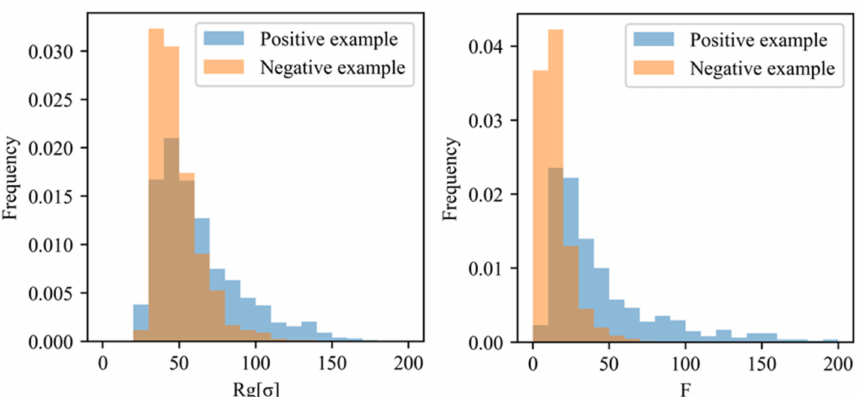
Figure 14. Histograms of the radius of gyration, R g , and the number of filler particles in the loop, F , of the filler aggregate extracted by the PH. The blue bars and orange bars denote the aggregates extracted from the positive and negative examples, respectively.